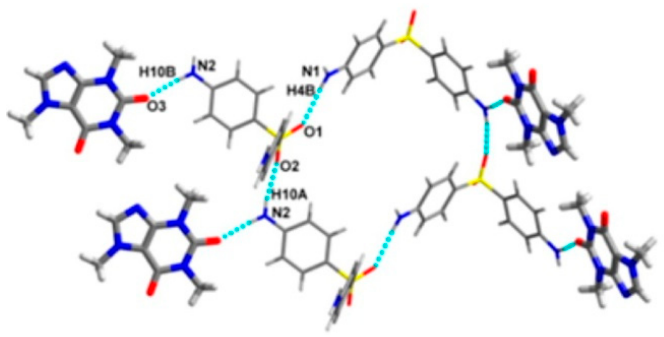
Figure 19. Hydrogen bond interaction present in dapsone-caffeine 1:1 cocrystal. Adapted with permission